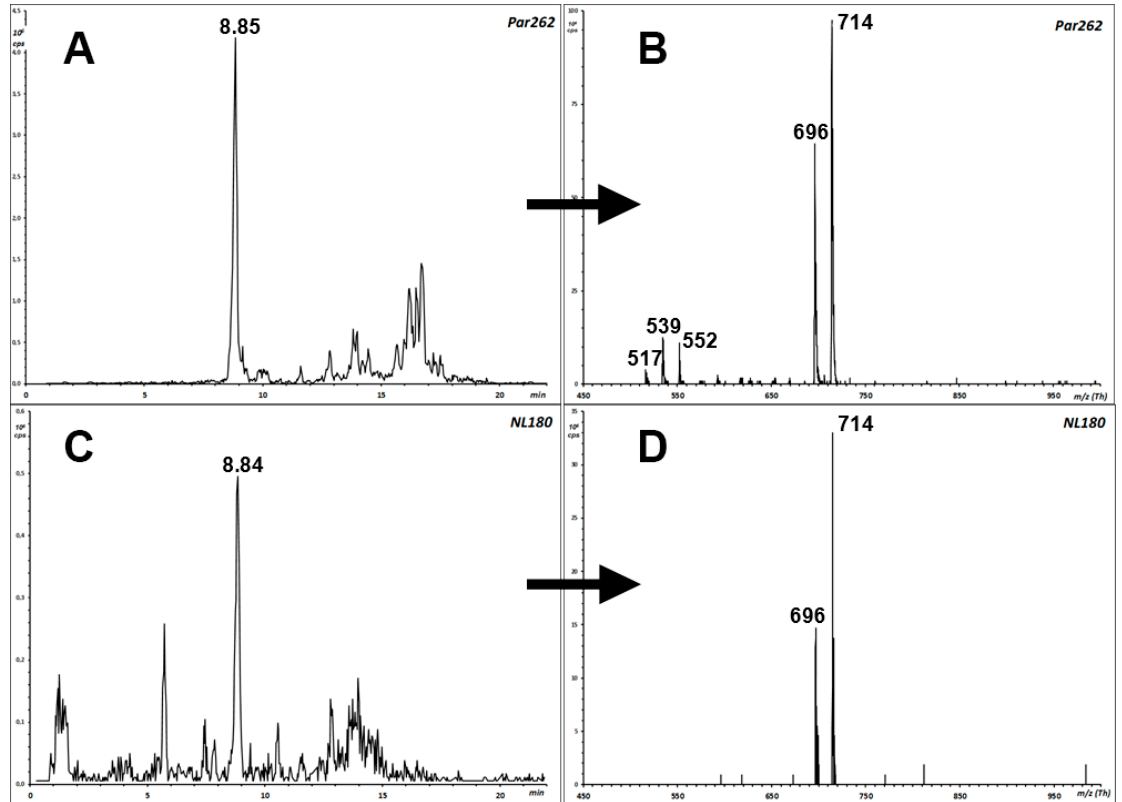
Figure 4. Confirmation of an unexpected hexose-containing ceramide species in the extract of an almond cultivar. The highlighted peak in panels ( A , C ) is that of compound A1. m / z 714 is the molecular mass (MH + ) in both experiments (Par262, panel ( B ), and NL180, panel ( D ). m / z 696 derives from MH + by water loss (panels ( B , D )). In Par262 (panel ( B )) m / z 552 and 534 derive from the previous ones by the loss of hexose.